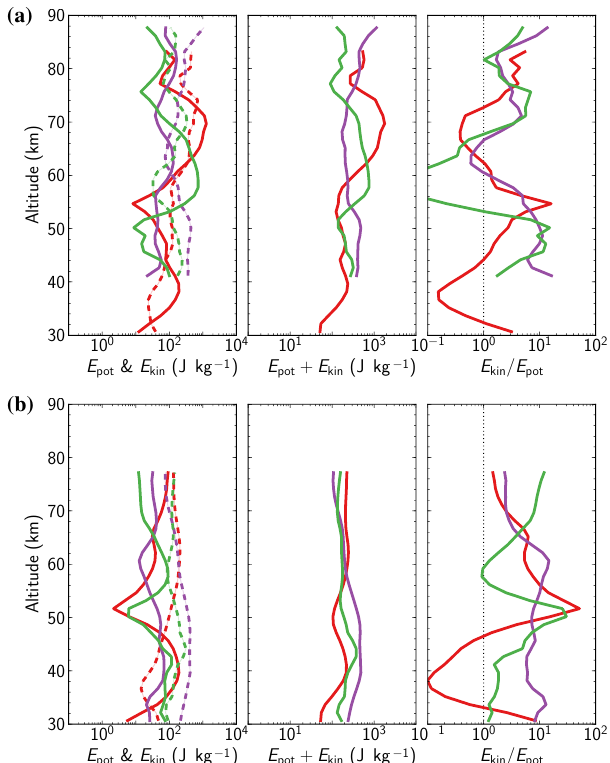
Figure 8. January energy densities per unit mass for large-scale waves for 2012 (red), 2014 (purple), and 2015 (green) derived from lidar data (a) and ECMWF data (b) ; see text for details. Left: po- tential (solid) and kinetic (dashed) LWEDs. Middle: total LWED. Right: kinetic-to-potential LWED.